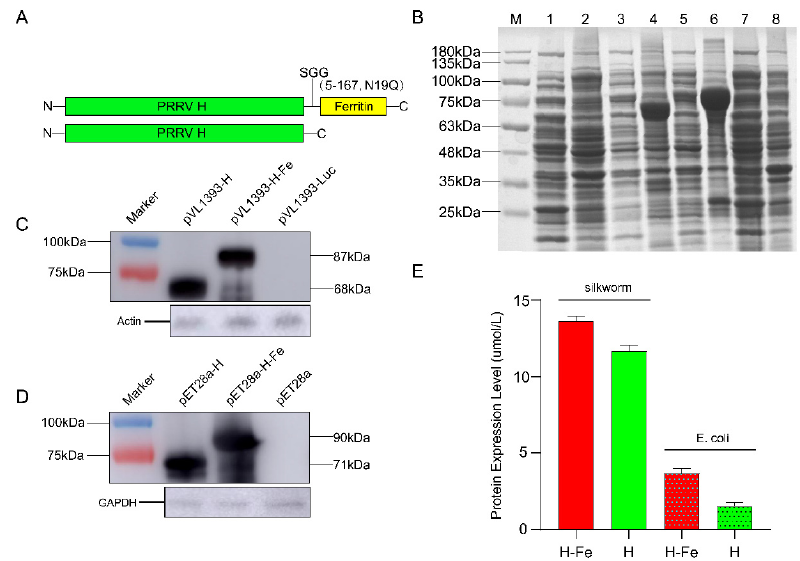
Figure 1. Construction and expression of the H-Fe and H proteins. ( A ) Molecular design maps of H-Fe and H sequences. ( B ) SDS-PAGE analysis of recombinant pET-28a-H-Fe and pET-28a-H expressed in E. coli Rosetta (DE3). Lane M, protein marker. Lane 1, pET-28a-H not induced and supernatant after sonication. Lane 2, pET-28a-H not induced and precipitated after sonication. Lane 3, pET-28a-H induced and supernatant after sonication. Lane 4, pET-28a-H induced and precipitated after sonication. Lane 5, pET-28a-H-Fe induced and supernatant after sonication. Lane 6, pET-28a-H- Fe induced and precipitated after sonication. Lane 7, pET-28a-H-Fe not induced and supernatant after sonication. Lane 8, pET-28a-H-Fe not induced and precipitated after sonication. ( C ) Western blot analysis of H-Fe and H recombinant proteins expressed in silkworm. The gray value of H-Fe and H protein bands were 32,076 and 45,489, respectively. ( D ) Western blot analysis of H-Fe and H recombinant proteins expressed in E. coli . The gray value of H-Fe and H protein bands were 33,518 and 49,246, respectively. ( E ) Detection of H-Fe and H protein expression level. Expression levels of silkworm-expressed proteins were measured by ELISA. Expression levels of E. coli -expressed proteins measured were by